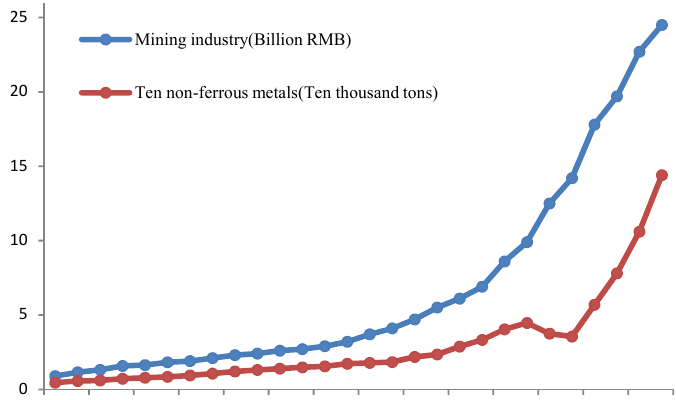
Figure 3. Profiles of the ten main non-ferrous metals by productions and values in Suxian district,